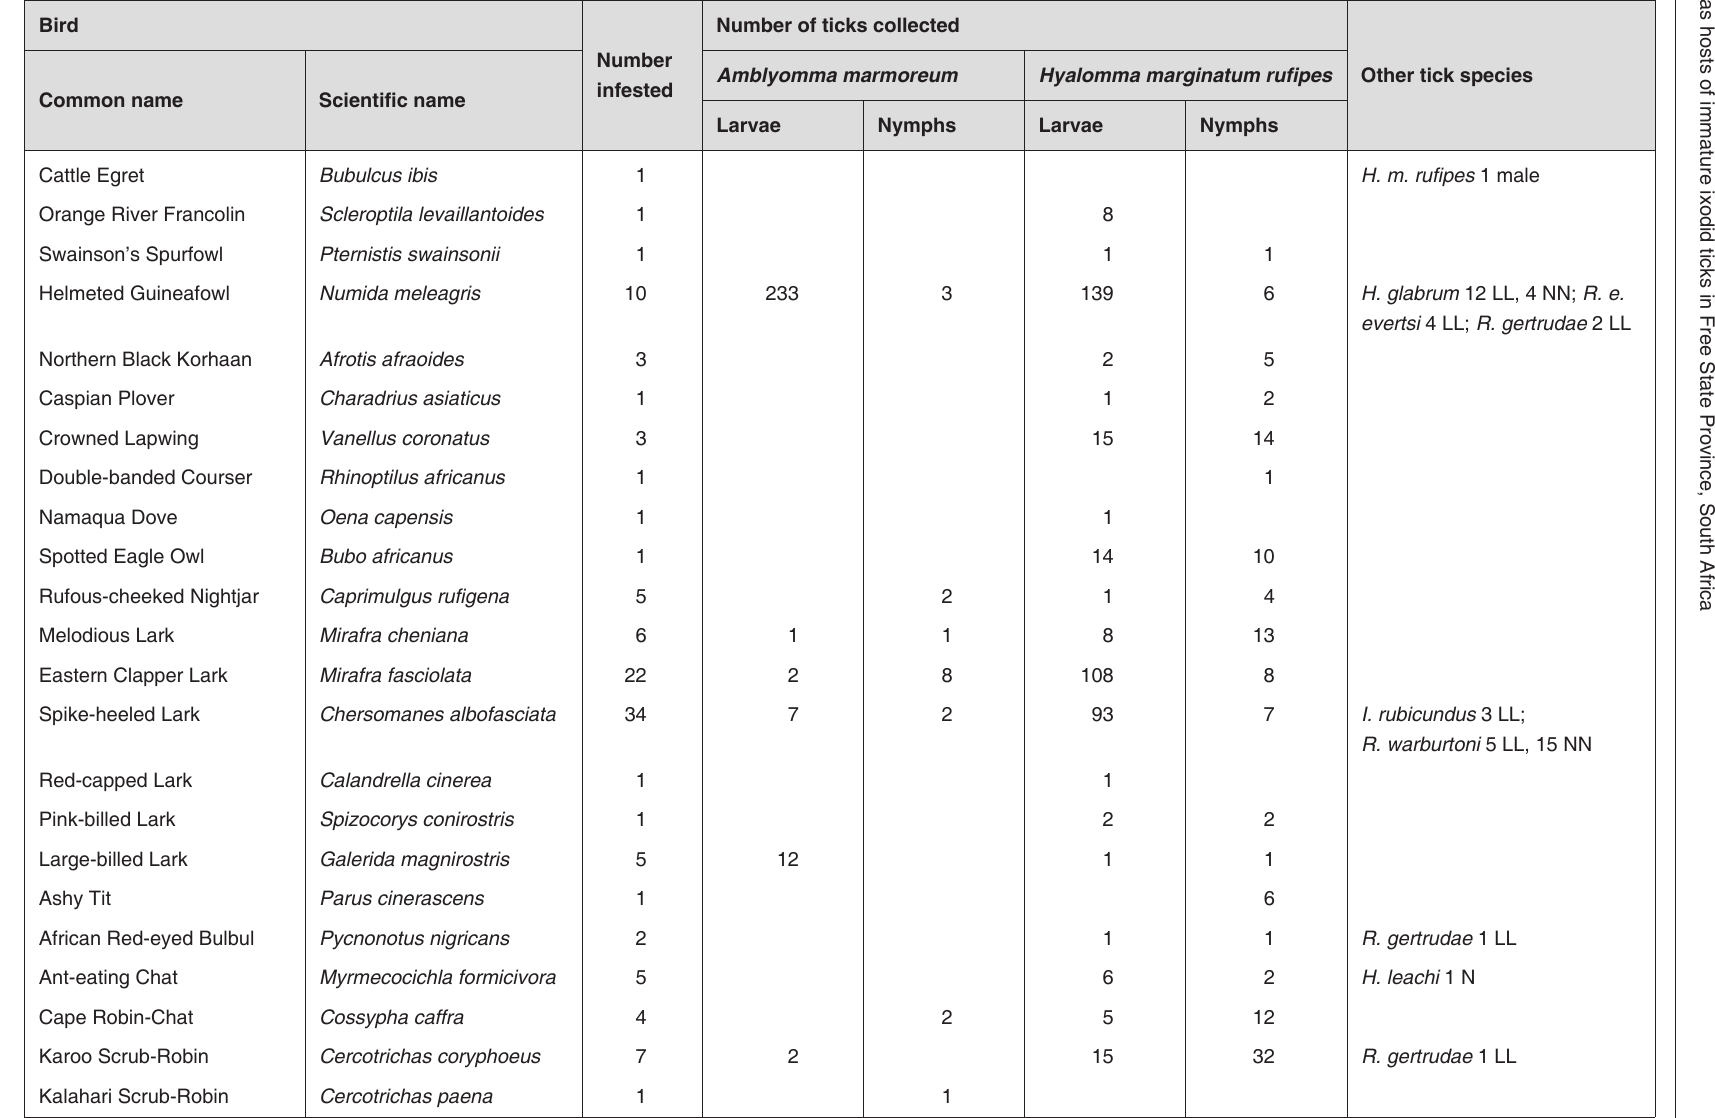
TABLE 2 Ixodid ticks collected from birds in Free State Province, South Africa. Bird names and sequence according to Maclean (1993) and Hockey et al . (2005)